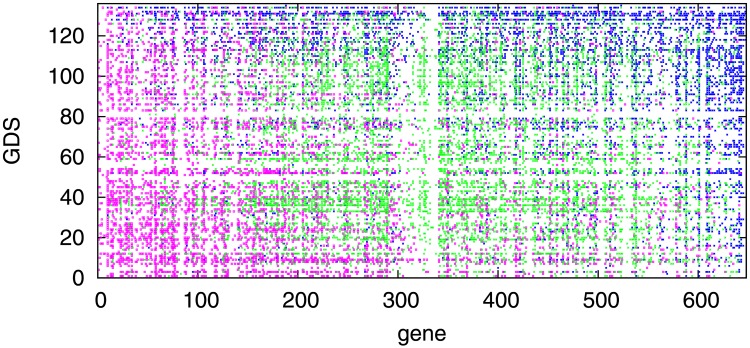
The classification results for all 647 regulated genes and for all 135 GEO DataSets.Blue represents the correlation type, magenta represents the horizontal-distribution type, green represents the vertical-distribution type, and the white areas with no points represent the no-change type or unclassified. Elements on both axes were arranged in the order of the descending proportion of the horizontal-distribution type.